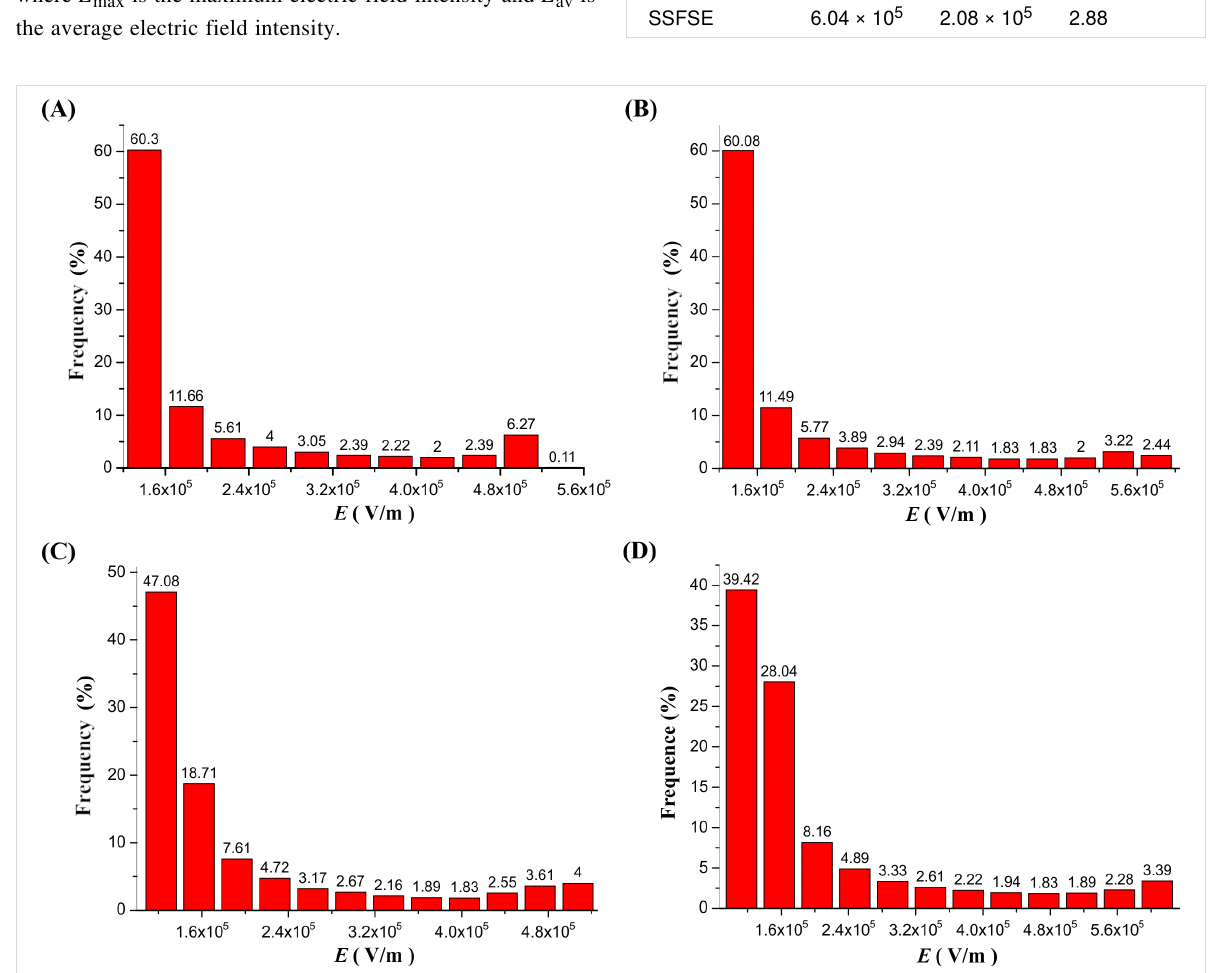
Figure 9: Distribution of the electric field along the vertical axis from the center of the solution surface to the collector (0–180 mm). A, B, C and D cor- respond to the MBE, MFSE, OSFSE and SSFSE device.